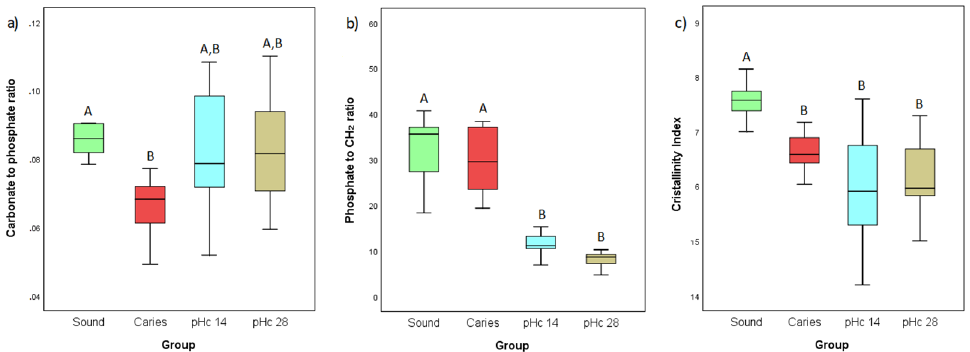
Figure 4. Results for Raman mineralisation variables. ( a ) Carbonate to phosphate ratio, ( b ) Carbonate to CH 2 ratio, and ( c ) Crystallinity Index. Different uppercase letters show statistical differences among groups ( p < 0.05).